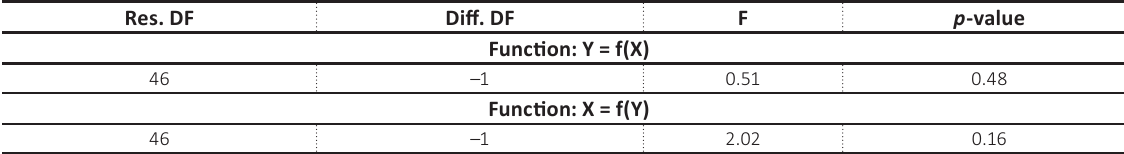
Table E3. Ranking in 50 largest economies (X) and government corporate ESG disclosure (Y) Res. DF